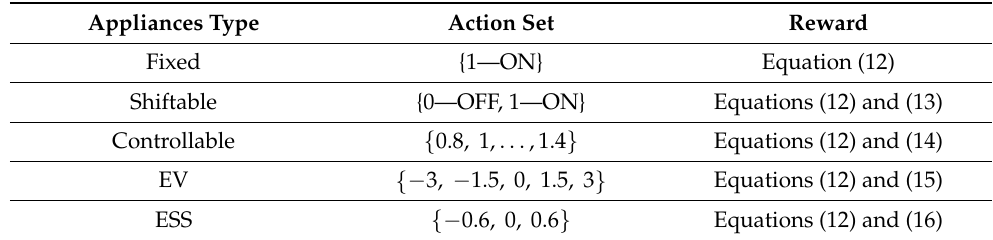
Table 2. State, action, and reward for each appliance